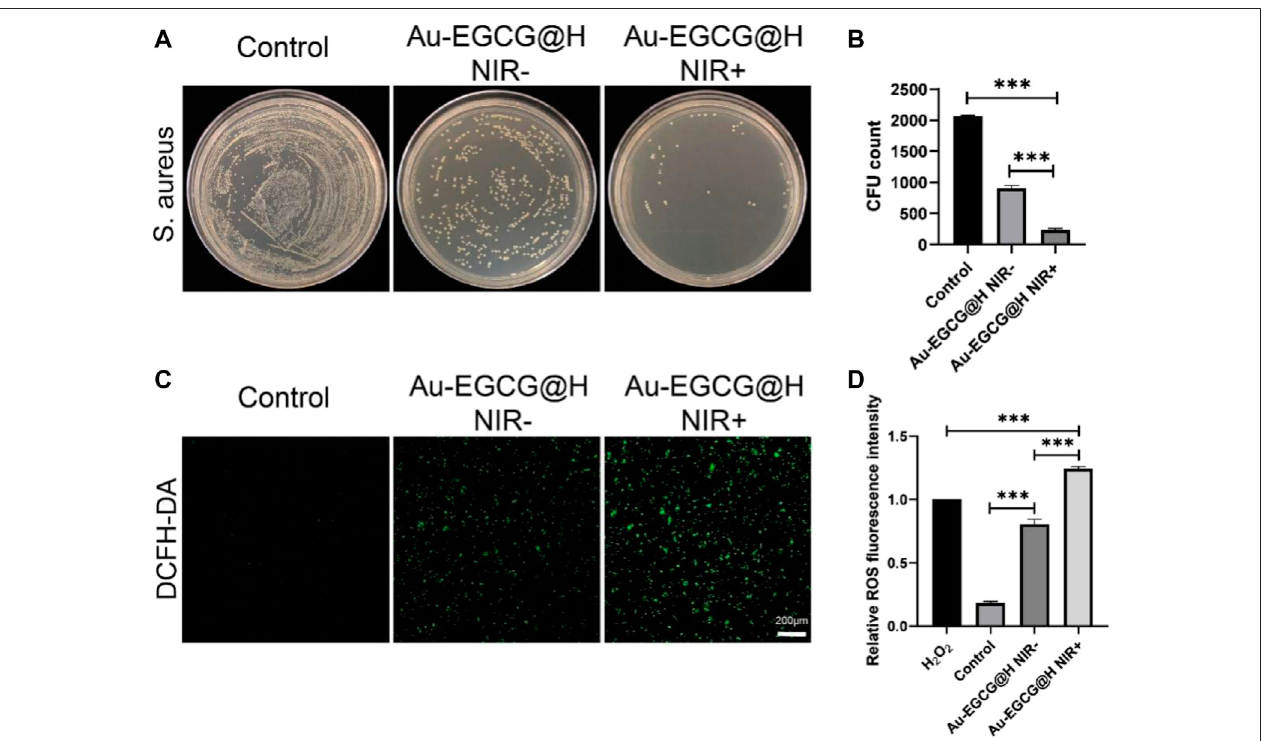
FIGURE 2 | effectiveness of Au-EGCG@H laser irradiation for sterilization. (A) S. aureus agar plate photos of distinct treatments. (B) The corresponding colony- forming unit (CFU) amount of S. aureus with different treatments. (C) In vitro reactive oxygen species (ROS) effects with various treatments. Stained by 2,7- dichlorodihydro fl uorescein diacetate (DCFH-DA), bar (cid:2) 20 μ m. (D) The relevant statistical histogram revealing the relative ROS fl uorescence intensity. * p < 0.05, ** p < 0.01, *** p < 0.001.